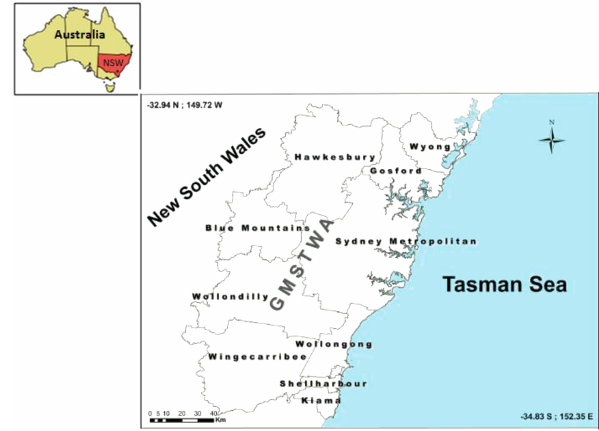
Figure 1. The location map of the study